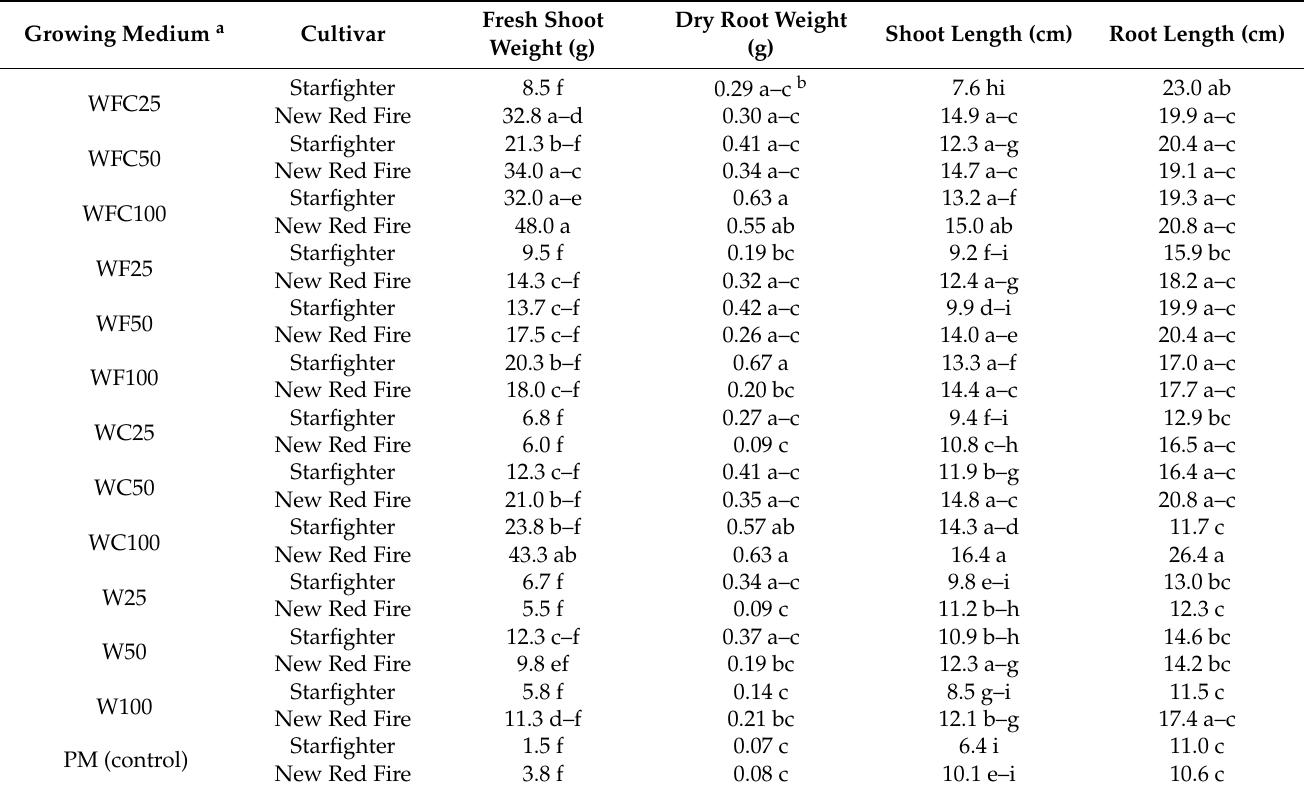
Table 7. Interaction effects of growing medium and type of cultivar on dry root weight, shoot and root length of lettuce in Trial